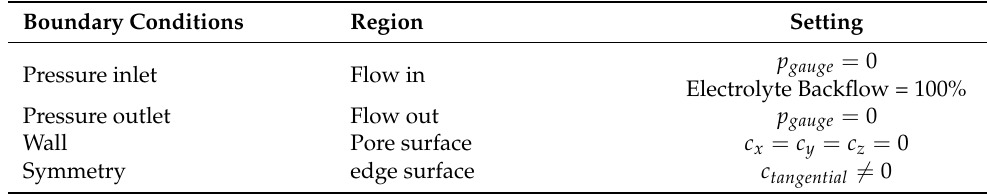
Table 2. Boundary conditions for the micro